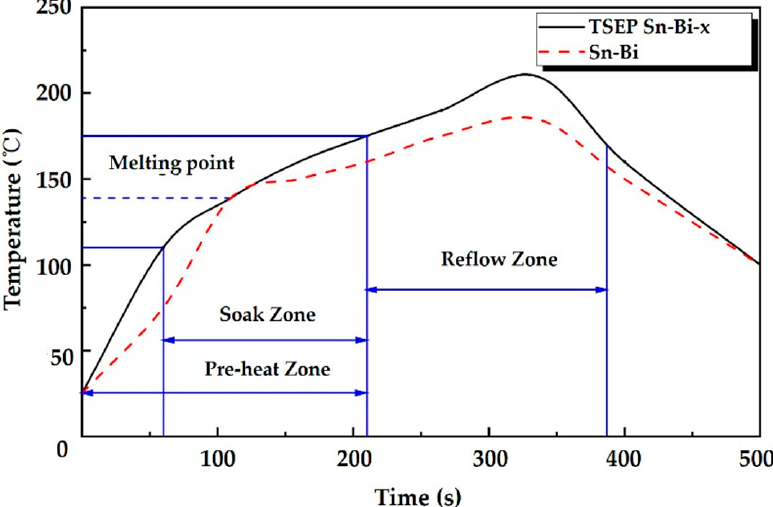
Figure 3. Reflow profile of the Sn–Bi solder paste and TSEP Sn–Bi-x solder pastes [20,22].